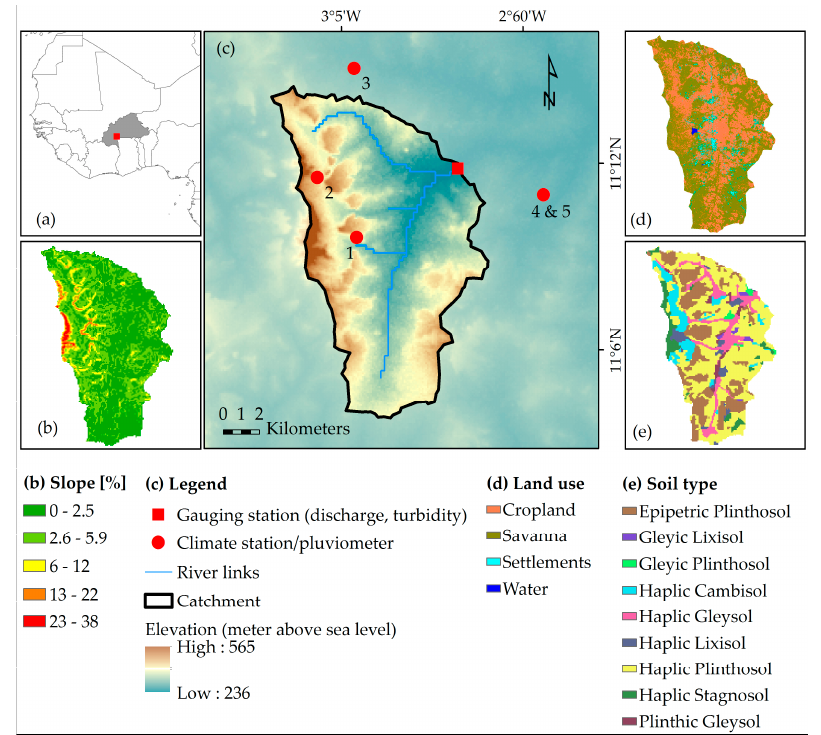
Figure 1. Location map of the Dano catchment: ( a ) location of the catchment and Burkina Faso in West Africa; ( b ) slope of the catchment; ( c ) model catchment; ( d ) land use map [53]; ( e ) soil map (data